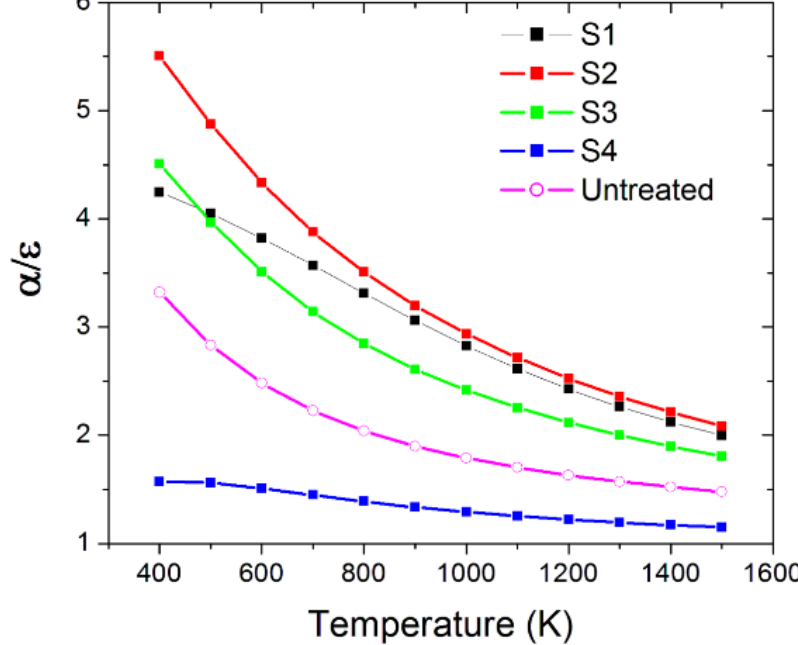
Figure 17. Spectral selectivity ( α / ε ratio) of the four nanotextured samples compared to the untreated material as a function of the temperature before the thermal annealing process.